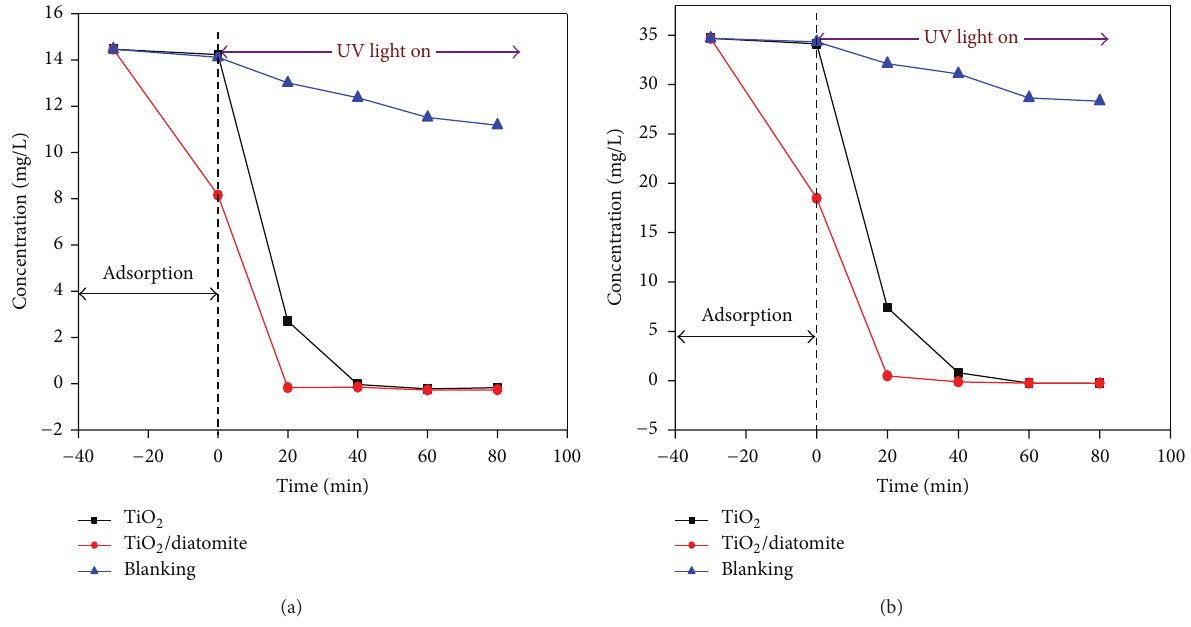
Figure 5: Kinetics of photocatalytic MB degradation from initial MB concentrations of 15 (a) and 35 mg/L (b).